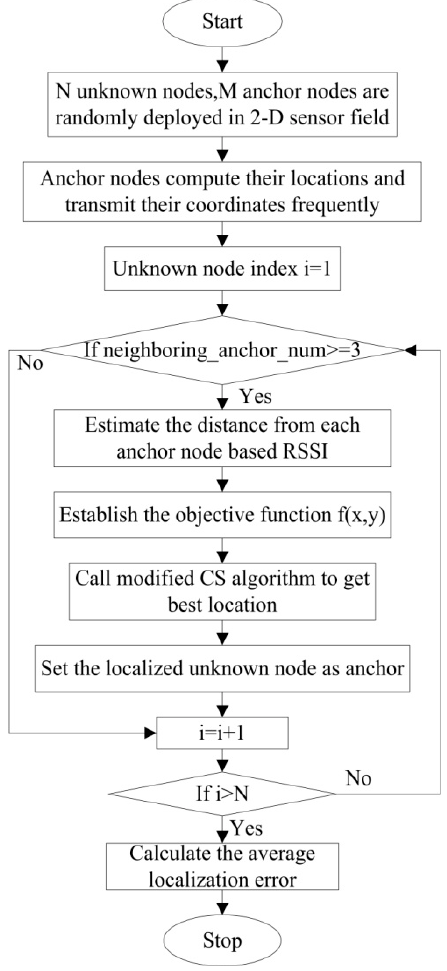
Figure 2. Flowchart of WSN node localization process based on modified CS algorithm.